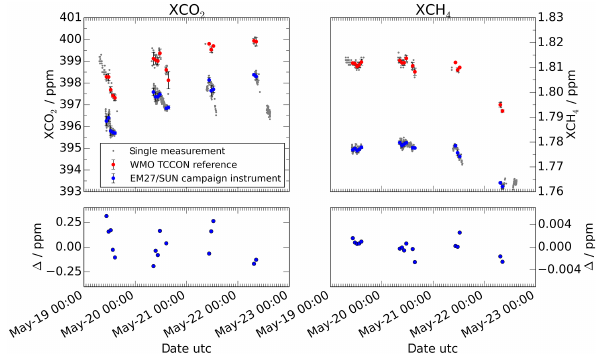
Figure 7. Post campaign measurements in Karlsruhe are used to retrieve the WMO-calibration factor for each gas. Hourly averages are taken for the TCCON reference (red) and the EM27/SUN mea- surements (blue). The calibration residual (lower panel) is defined as (cid:49) := (cid:104) X wmo (cid:105) h −(cid:104) X gas,wmo (cid:105) h